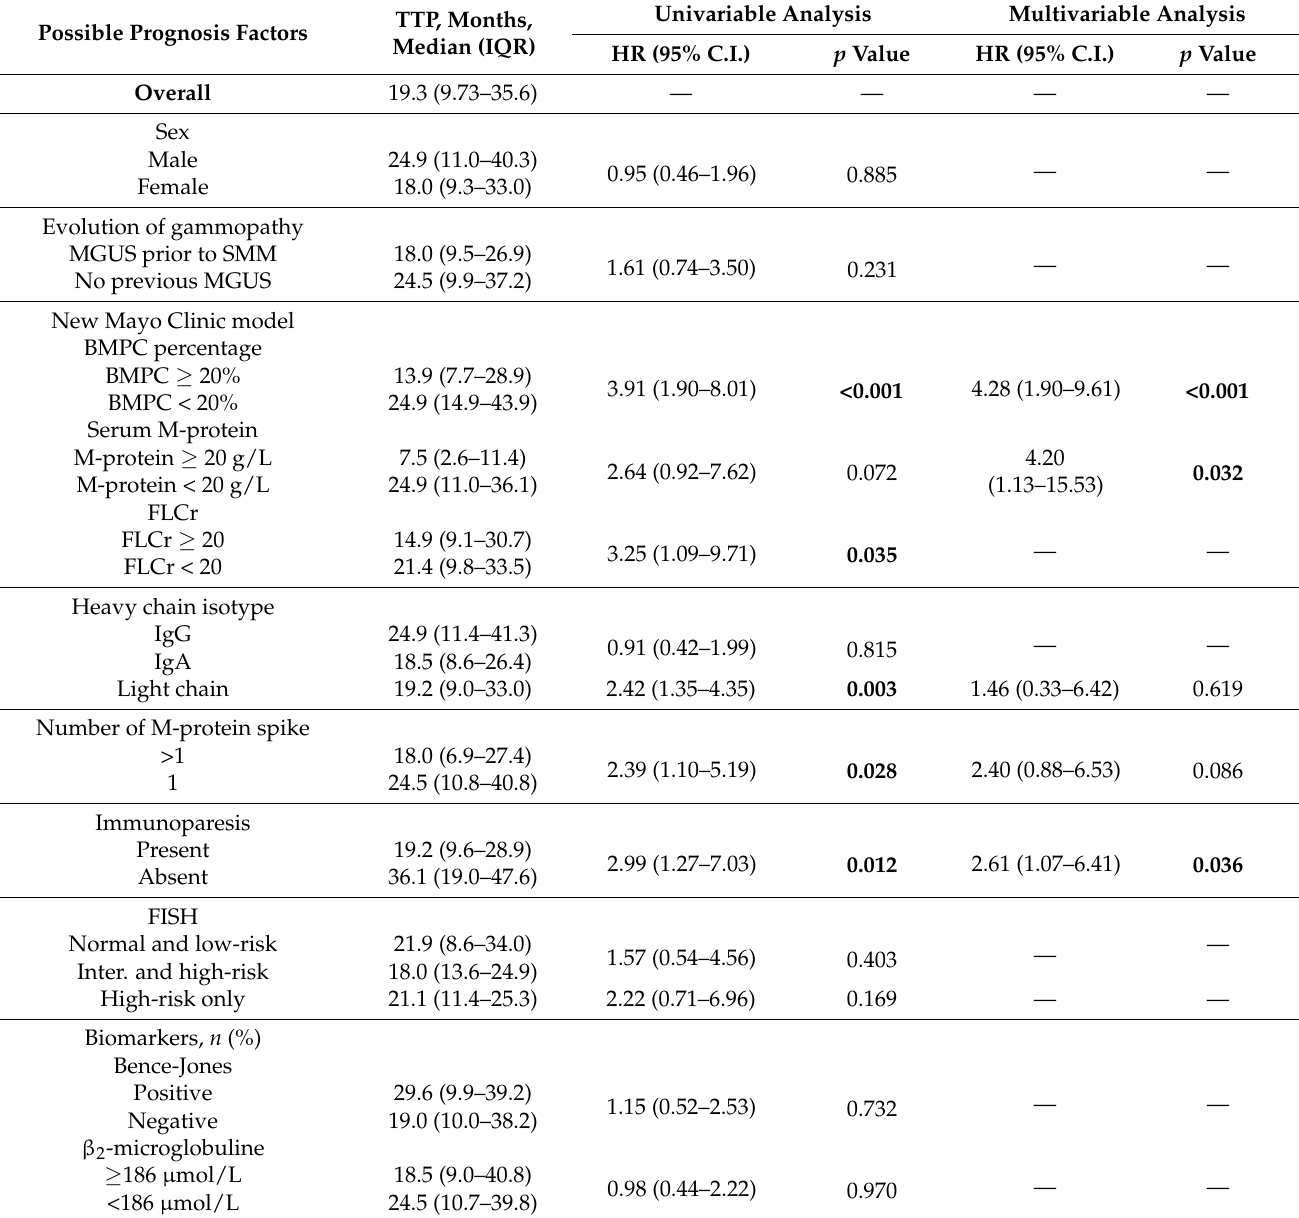
Table 3. Univariable and multivariable analysis of the impact of possible prognosis factors on TTP. Possible Prognosis